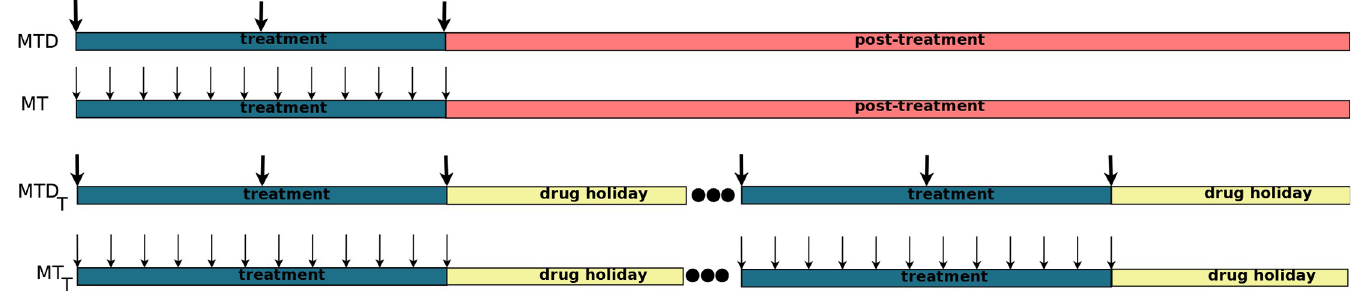
PLOS Computational Biology | https://doi.org/10.1371/journal.pcbi.1008234 October 5,